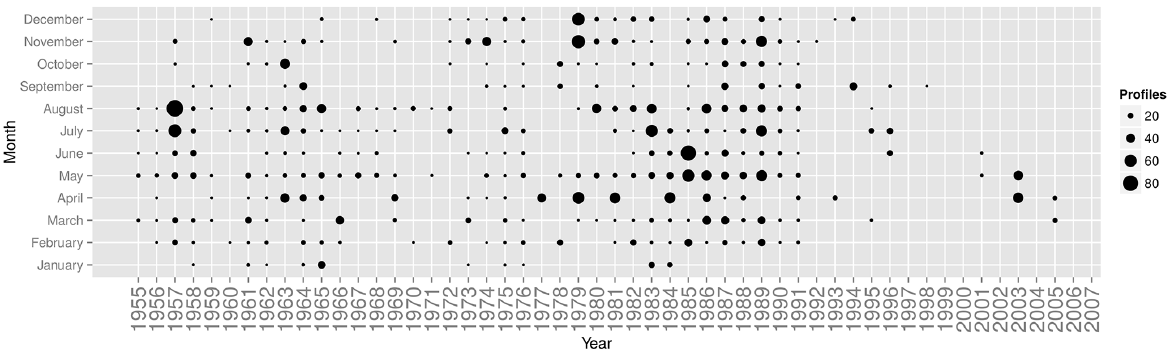
Figure 2. Temporal distribution of the ship-based oxygen profiles merged from the World Ocean Database, R/V Knorr 2003 and R/V Endeavor 2005 campaigns. Only the profiles containing at least five observation depths, one observation above 30m depth and one record with [O 2 ] < 20 µM were